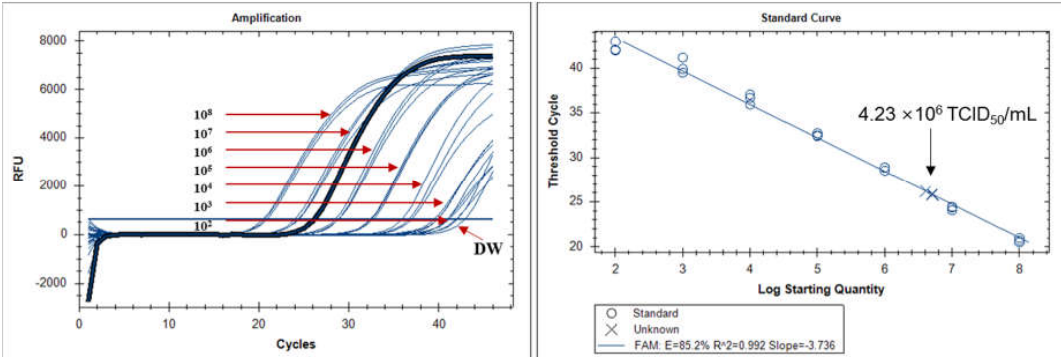
Figure 6. Assessment of fluorescent immunochromatographic strip test (FICT) performance by qRT- PCR. The linear relationship between the cycle threshold (Ct) and RNA copy number of respiratory syncytial virus (RSV) nucleoprotein (NP) was used to produce a standard curve (left panel). The right panel indicates the Ct value (Y-axis) and the RNA copy numbers (X-axis) at a virus titer (4.23 × 10 6 TCID 50 /mL) corresponding to the limit of detection of the FICT.